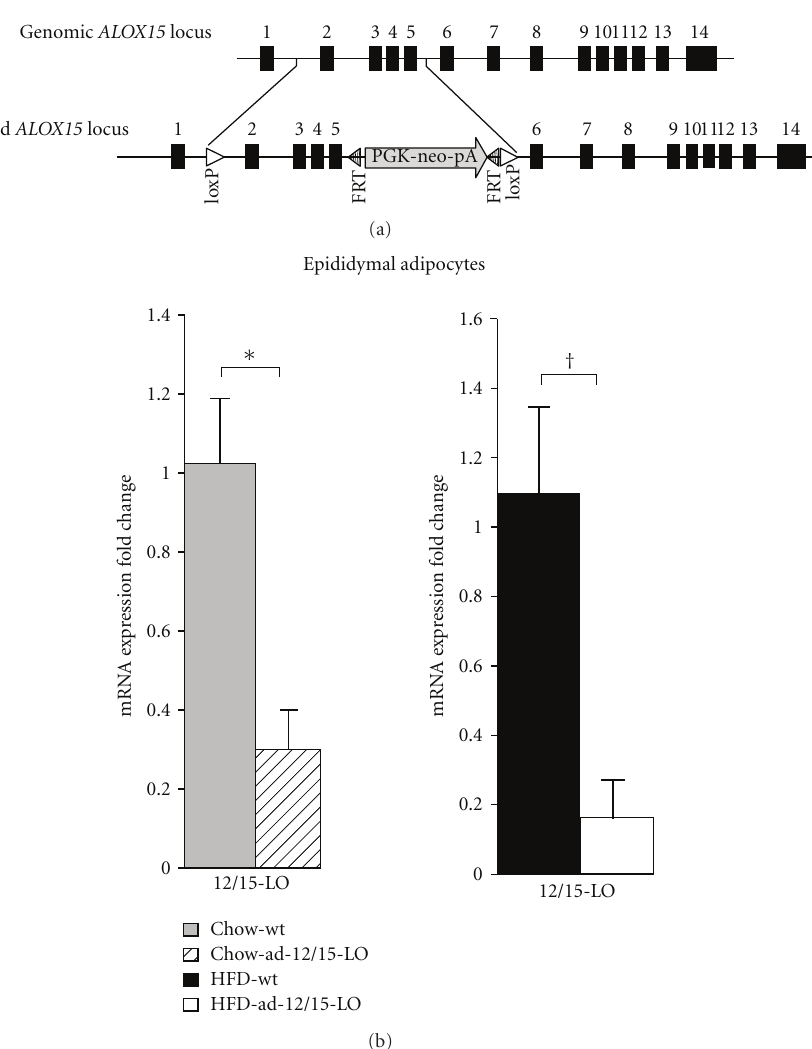
Figure 1: The generation of a targeted conditional knockout allele for the mouse 12/15-lipoxygenase gene, ALOX15 . (a) The targeted ALOX15 locus contains loxP sites that flank exons 2 and 5 and a neomycin (neo) cassette selection marker flanked by FRT sites inserted in intron 5. The neo cassette is driven by the mouse phosphoglucokinase gene (PGK) promoter and contains a polyadenylation (pA) signal to terminate the neomycin expression. Exons are depicted as blackened boxes, loxP sites as white triangles, and FRT sites as striped triangles. (b) 12/15-LO mRNA expression was measured in isolated epididymal adipocytes by RT-PCR. All data was normalized to total actin, and the fold changes in expression were calculated relative to control. All data represent the means ± SEM; n = 3–6. ∗ P < 0 . 05 and † P < 0 . 02 versus